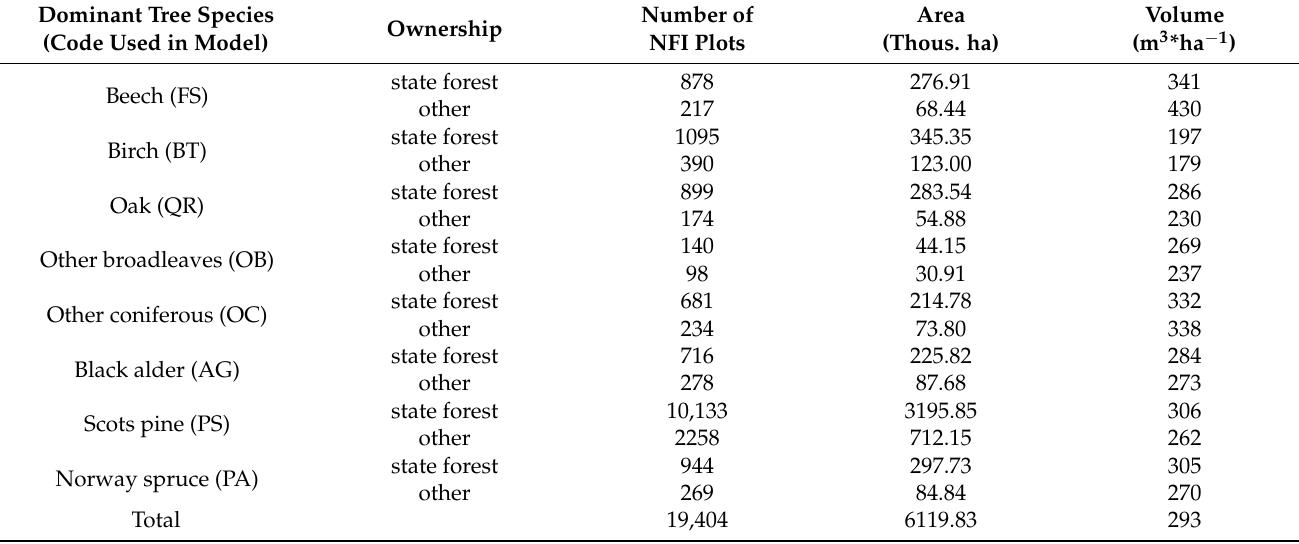
Table 1. Summary of the initial state of the forest (in reference period 2010–2014) used for the input to the EFDM and CBM-CFS3